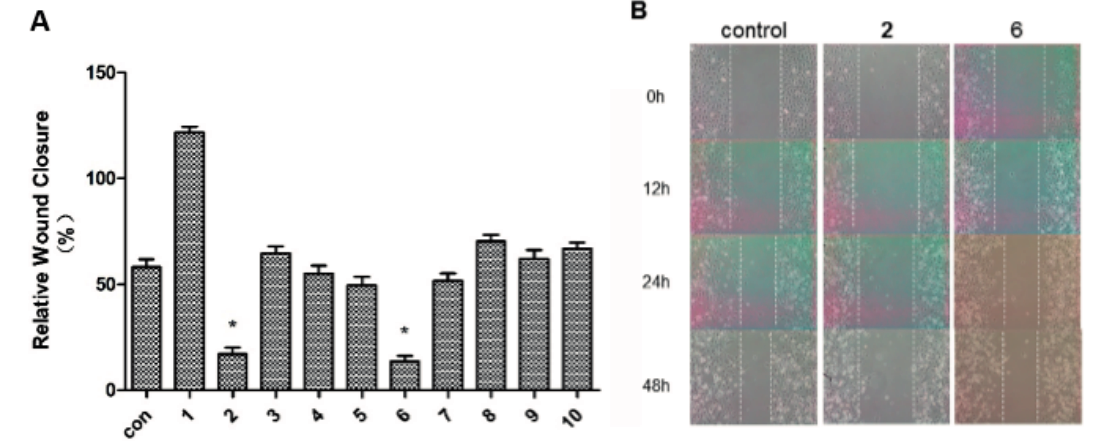
Figure 5. Wound-healing assays on compounds 1 – 10 with human breast tumor cell MDA-MB-231. ( A ) The antimigration effects of 1 – 10 at 10 μ M on the tumor cells ( ∗ p < 0.05); ( B ) The incubation of 2 and 6 with tumor cells at 0, 12, 24, and 48 h (left: control; middle: 2 at 10 μ M; right: 6 at 10 μ